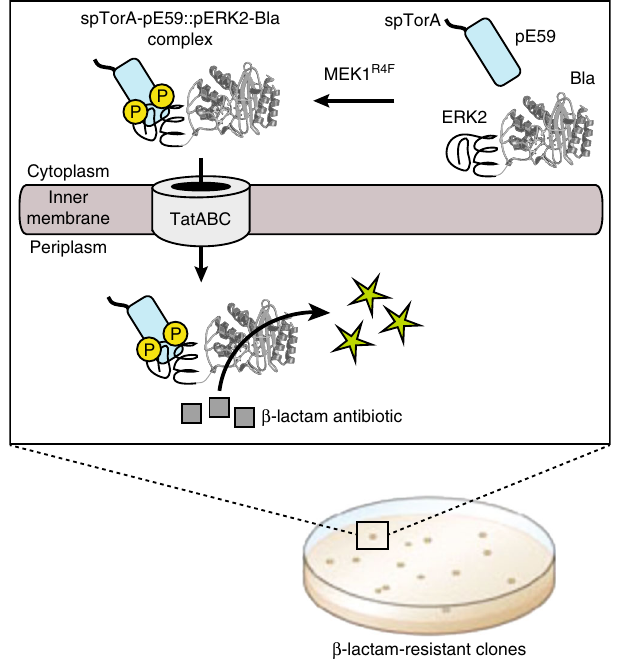
Fig. 1 PhLI-TRAP-based isolation of phospho-speci fi c binding proteins. Schematic representation of engineered assay for co-translocation of interacting receptor-antigen pairs via the Tat translocase (TatABC). The assay enables discovery and optimization of synthetic binding proteins (e.g., DARPins) with af fi nity for phospho-modi fi ed target antigens simply by demanding bacterial growth on β -lactam antibiotics such as carbenicillin (Carb), without the need for puri fi cation or immobilization of the phosphoprotein target. The Tat signal peptide chosen was spTorA, the reporter enzyme was Bla, the synthetic binding protein was an ERK2- or pERK2-speci fi c DARPin, and the antigen was ERK2. Phosphorylation status of ERK2 was toggled by expression of the constitutively active upstream kinase MEK1 R4F , which doubly phosphorylates (yellow P circles) ERK2 in the cytoplasm of living E. coli